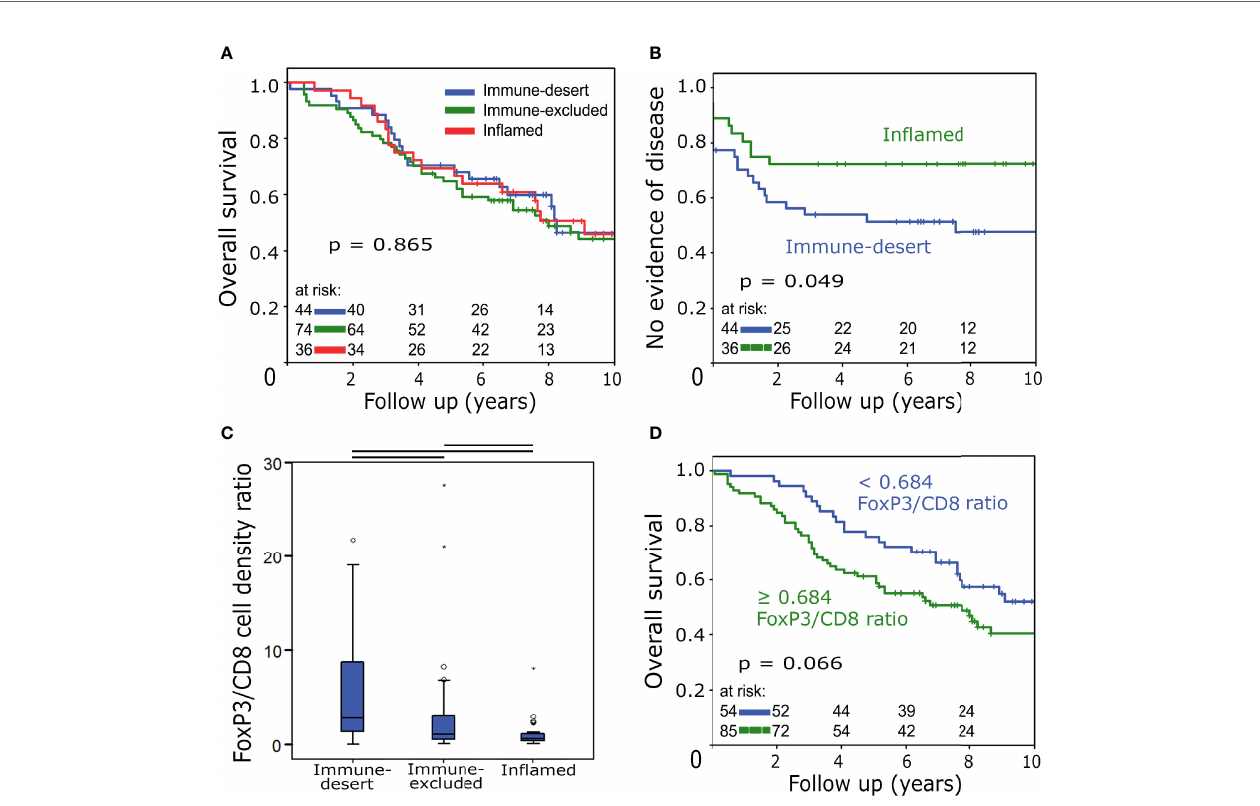
FIGURE 4 | (A) Overall survival analysed with the Kaplan-Meier method and log-rank test according to immune phenotypes. (B) No evidence of disease status analysed with the Kaplan-Meier method and log-rank test according to immune phenotypes. (C) Boxplots of stromal FoxP3+/CD8+ cell density ratio distributions in different immune phenotypes. Horizontal black bars signify p < 0.05 in Student ’ s t-test. (D) Overall survival analysed with the Kaplan-Meier method and log-rank test according to the FoxP3+/CD8+ cell density